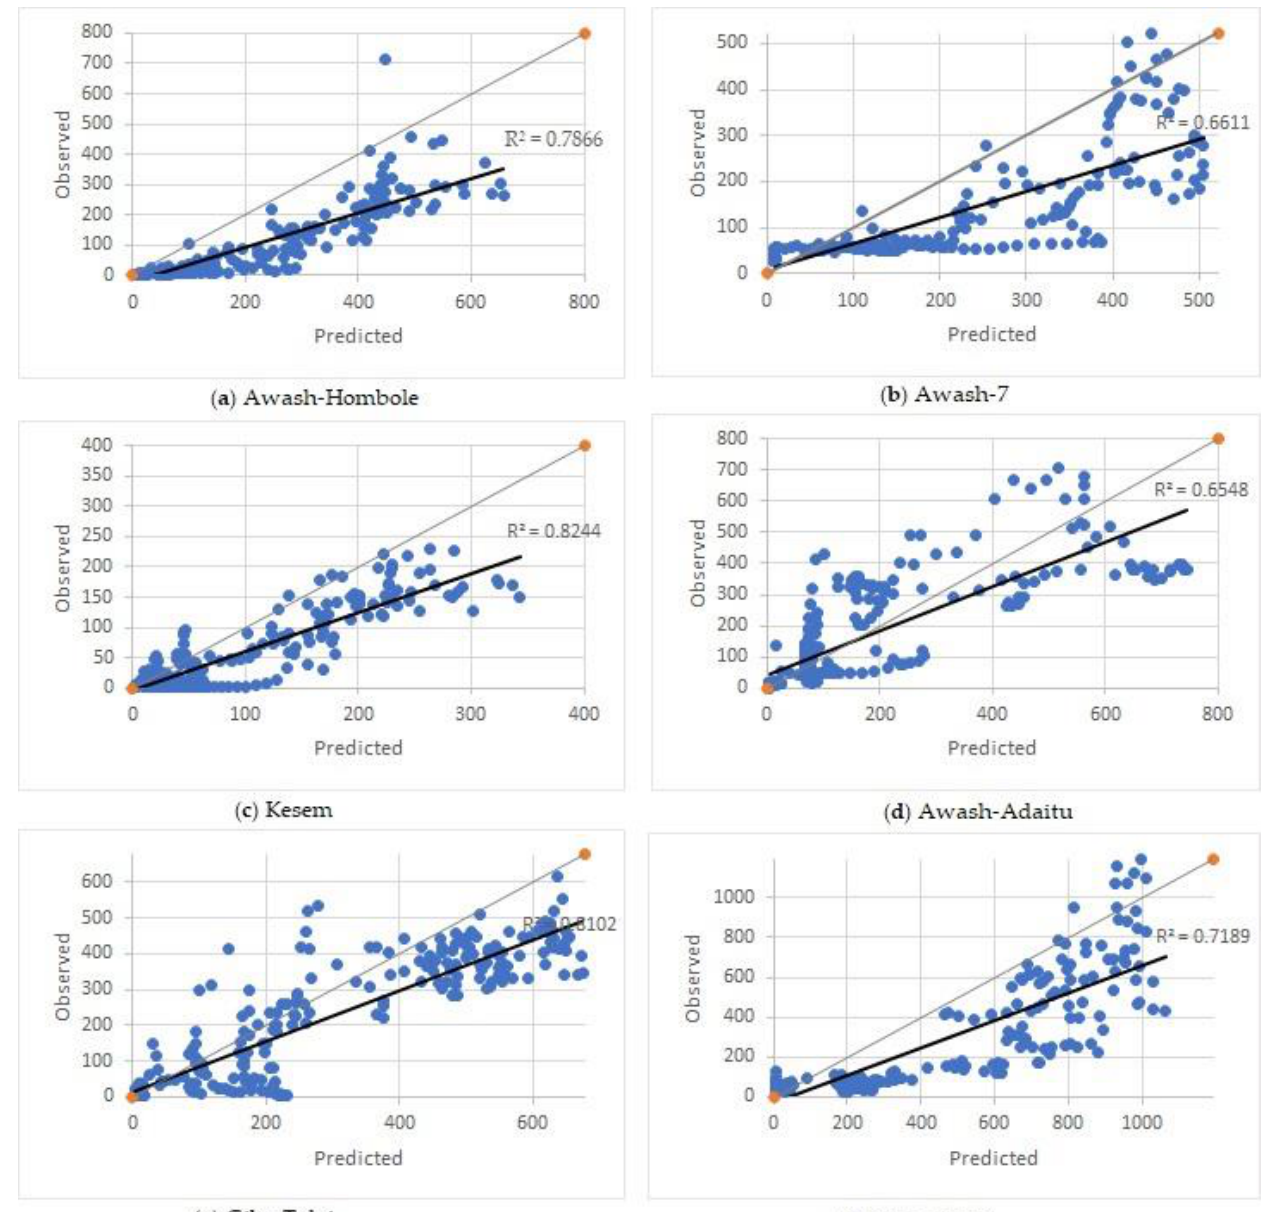
Figure 5. Observed vs. predicted runoff for selected rivers in Awash ( a – d ) and Omo-Gibe ( e , f ). Hydrographs for selected river stations from the continuous model simulation were produced using the 2005–2014 observation records. The time series plots for Awash- Hombole, Awash-7, Kesem, and Awash-Adaitu River stations in the Awash basin; and Gibe-Tolai and Gibe-Abelti River stations in the Omo-Gibe basin are presented in Figure